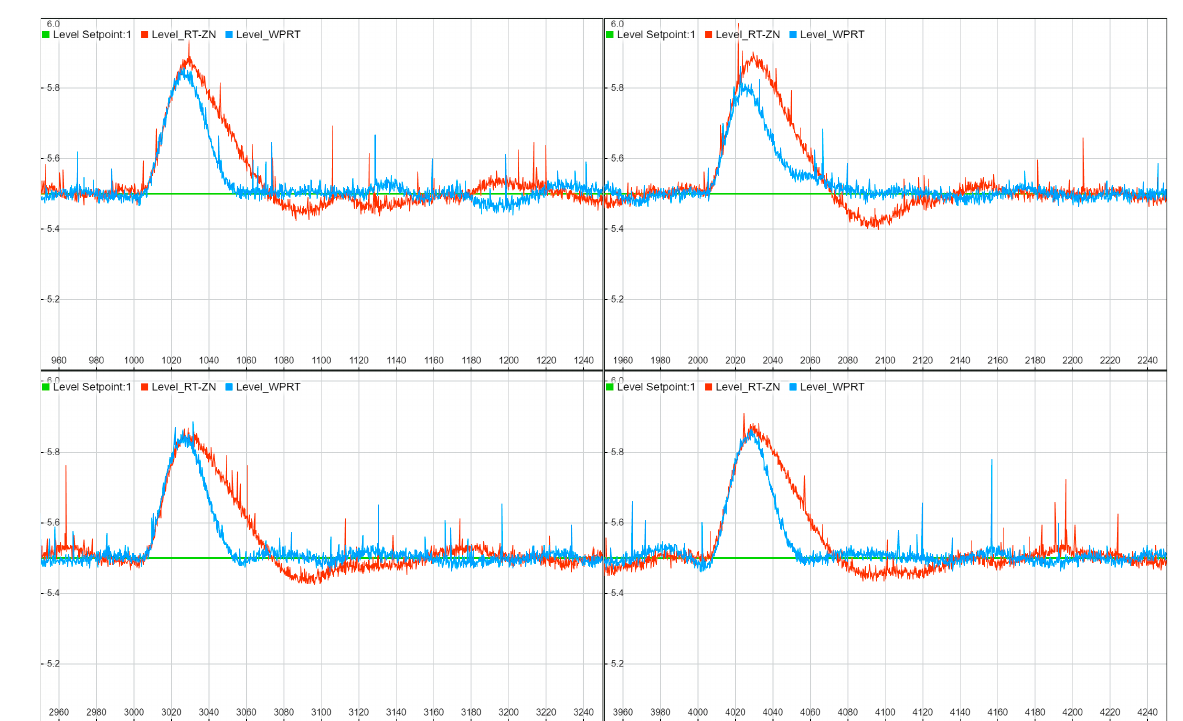
Figure 11. Process input disturbance test: The controller’s output, the setpoint flow rate of the feed water for the slave controller, was increased by 10 kg/s. Water-level setpoint (green), RT-ZN tuning (red), proposed WPRT method (blue).